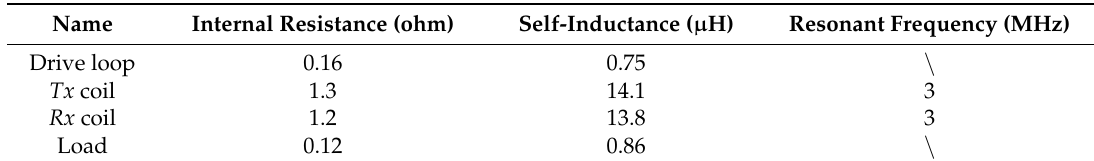
Table 3. Coil electrical parameters.